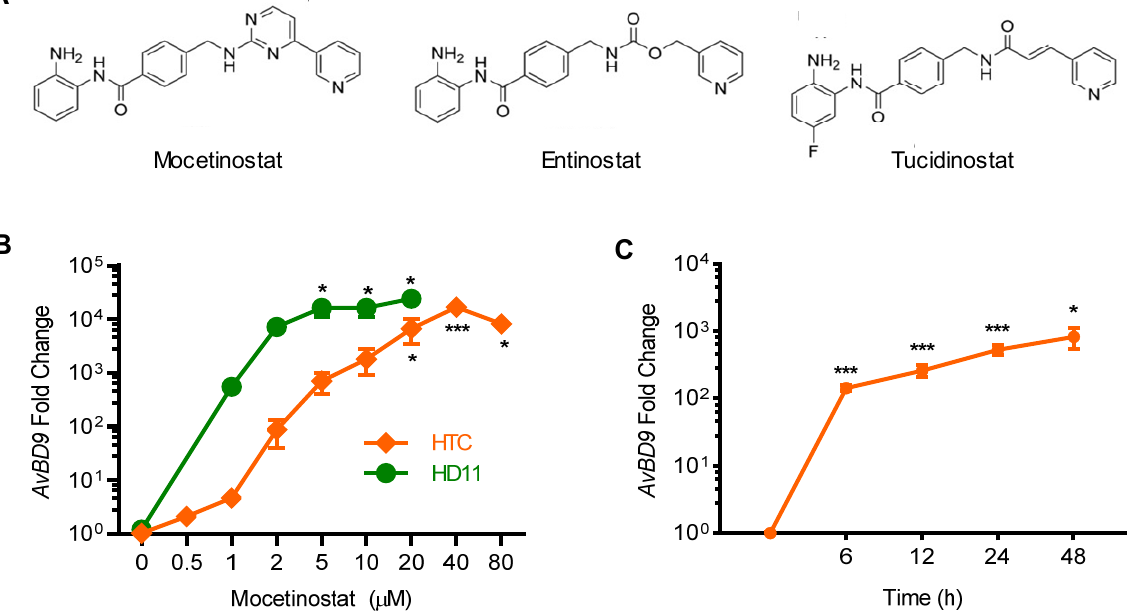
Figure 3. Dose- and time-dependent induction of AvBD9 mRNA expression by mocetinostat in two different chicken macrophage cell lines. ( A ) Chemical structures of mocetinostat and its two structural analogs, entinostat and tucidinostat. ( B ) Dose-dependent changes in AvBD9 mRNA expression